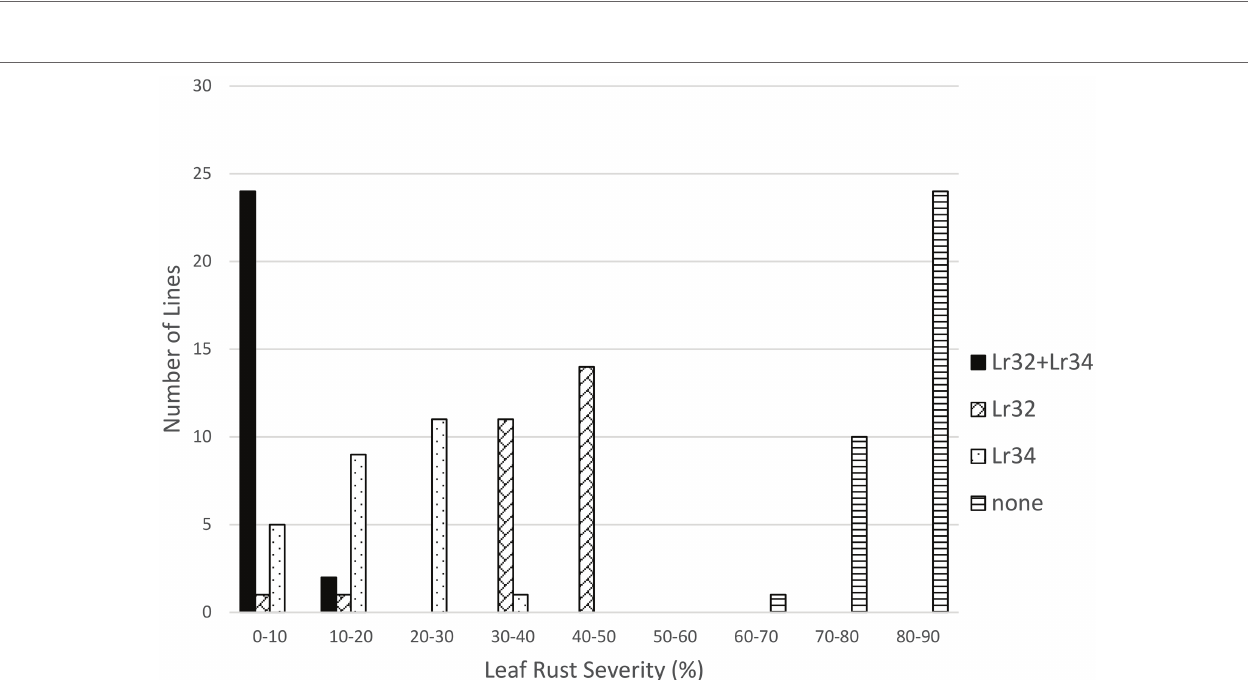
FIGURE 5 | Average leaf rust field severity (2012–2015) for progeny lines from the cross Lr32 /